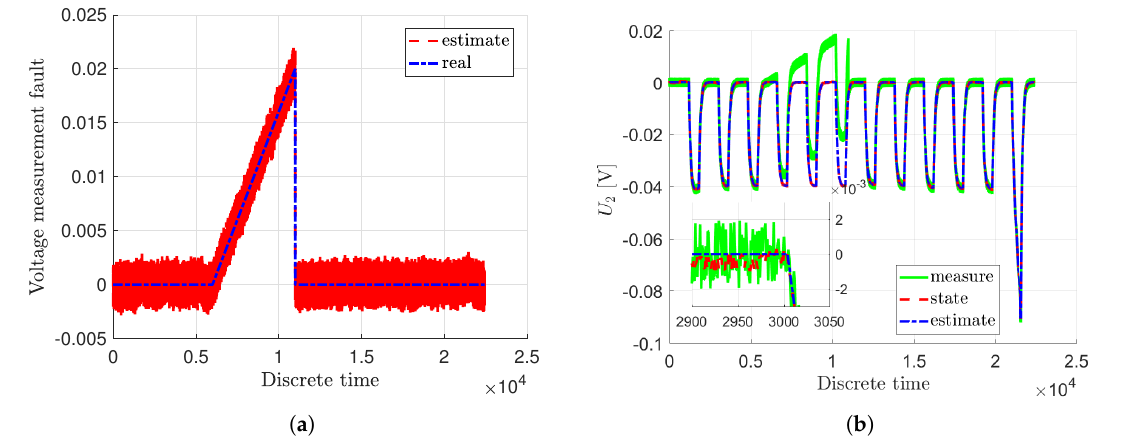
Figure 8. Slowly developing voltage measurement fault ( a ) and the response of the faulty system ( b ).